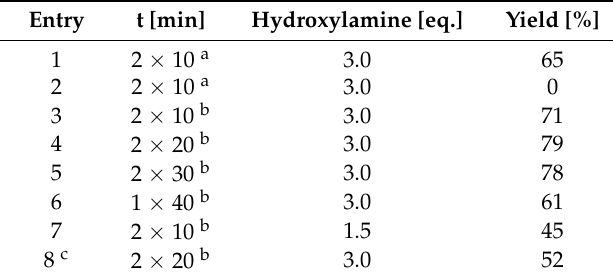
Table 6. Reaction conditions for the oxime preparation.